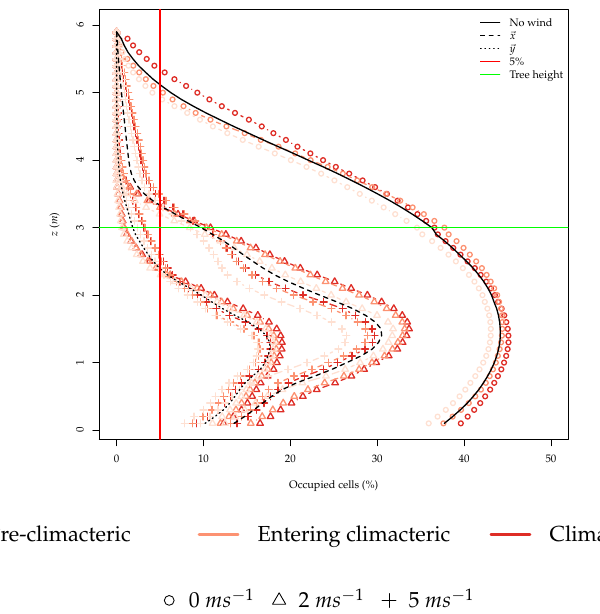
Figure 8. Percentage of occupied cells (cells with ethylene concentration higher than zero) in the environment across all time steps and simulations for the z-plane.